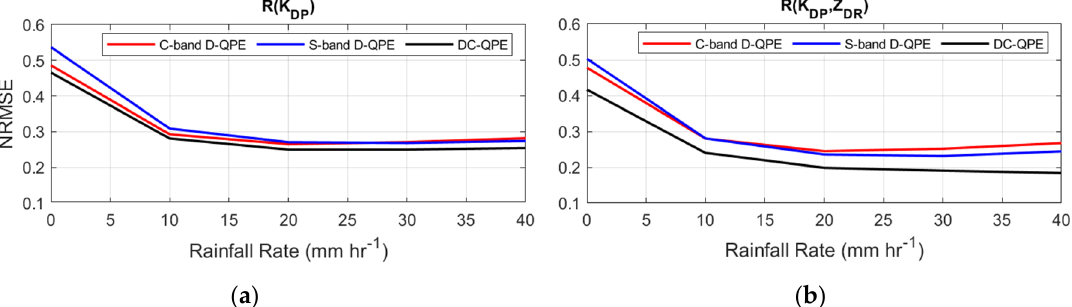
Figure 10. The NRMSEs of the C-band D-QPE, S-band D-QPE and DC-QPE from the ( a ) R(K DP ) and ( b ) R(K DP , Z DR ) algorithm.